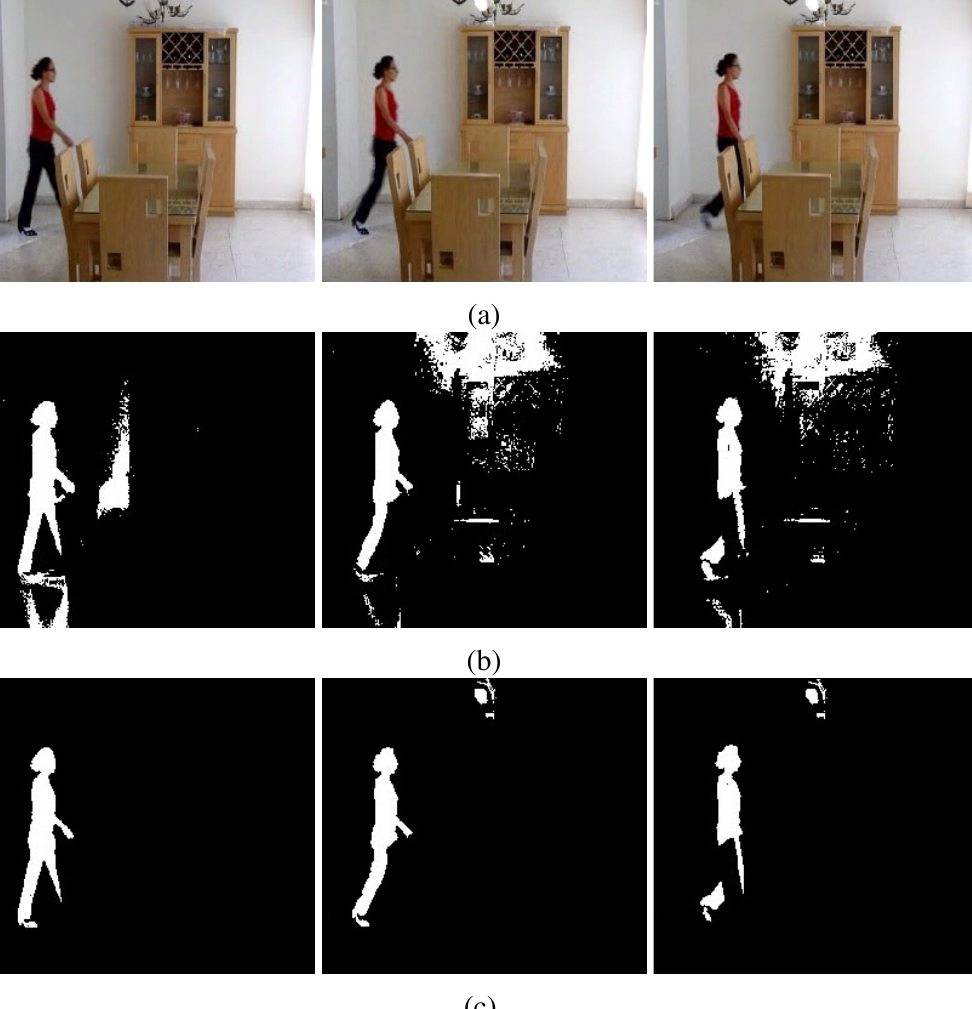
Figure 9. Foreground detection at a scene with sudden luminance change. In (a), we present a room, where light is turning on, the floor shows reflections and the wall shows soft shadows.